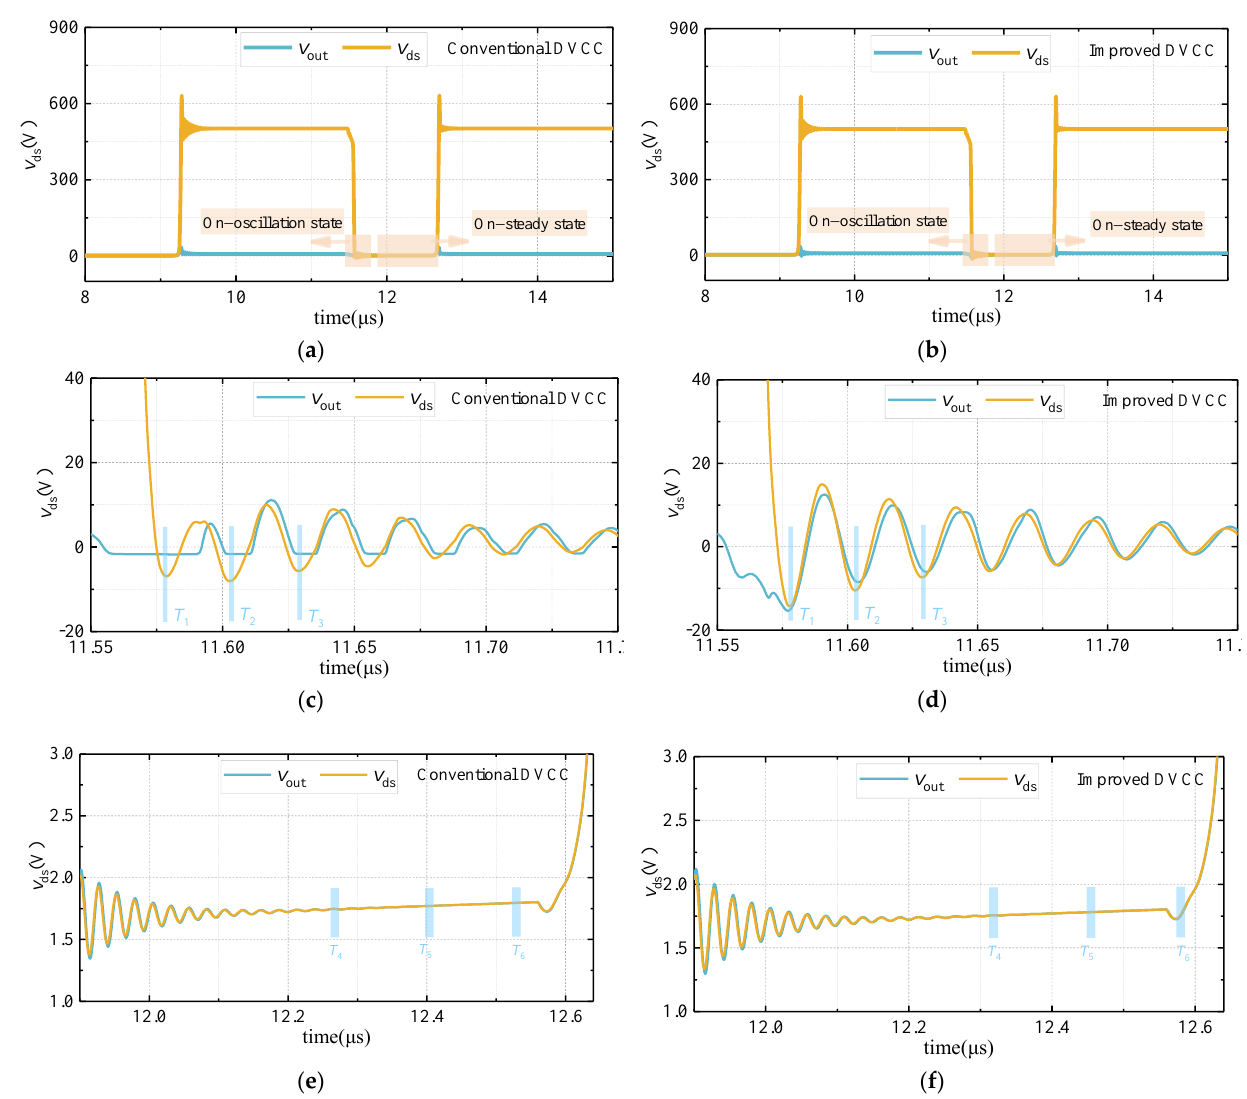
Figure 6. v out and v ds waveform comparison. ( a ) Waveform overview of the conventional DVCC; ( b ) waveform overview of the improved DVCC; ( c ) waveform of the conventional DVCC during the on-oscillation state; ( d ) waveform of the improved DVCC during the on-oscillation state; ( e ) waveform of the conventional DVCC during the on-steady state; ( f ) waveform of the improved DVCC during the on-steady state.